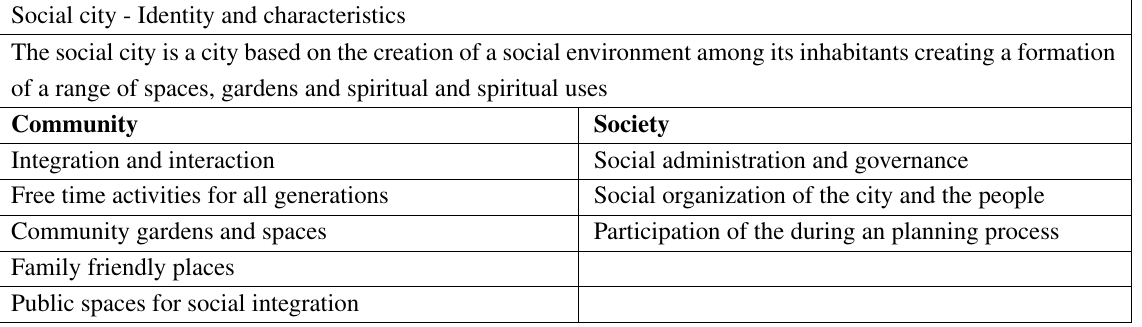
Table 4. Social city - Identity and characteristics